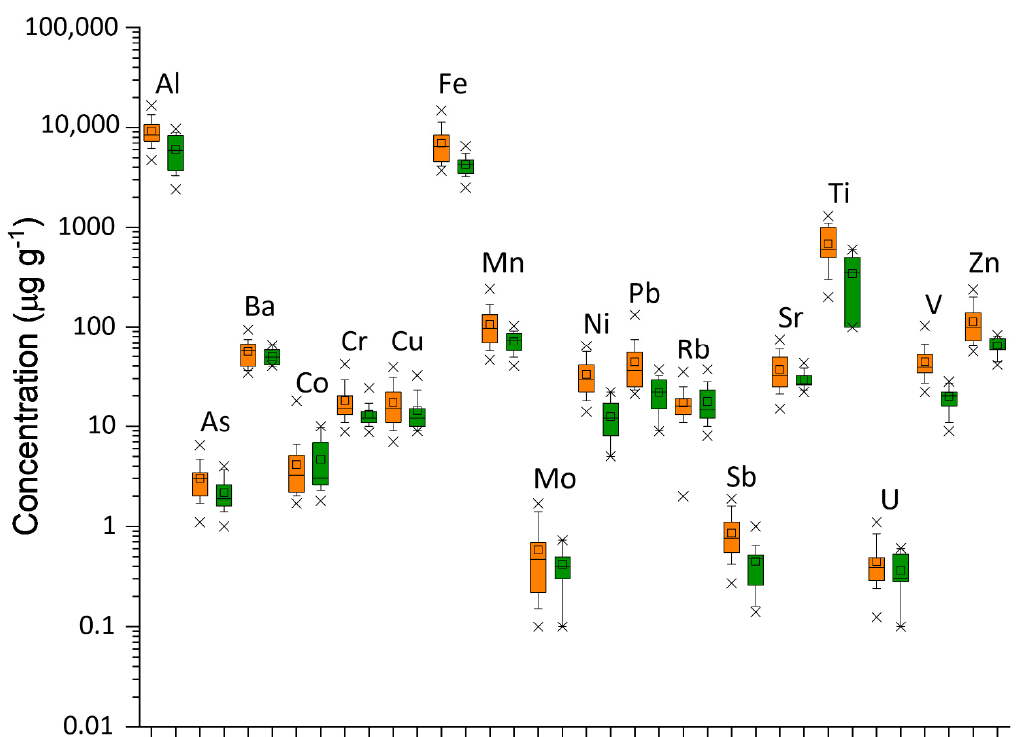
Figure 3. Box plot of chemical elements in the analyzed lichen samples. Boxes delineate the interquartile range (25–75%) with the indication of the median (dark line); a small square inside the box marks the mean value; whiskers indicate the 10–90% range; points outside the box are minimum and maximum values. Data are given in μ g g − 1 . Lichen samples IND (orange box); Lichen samples SUBIND (green box).